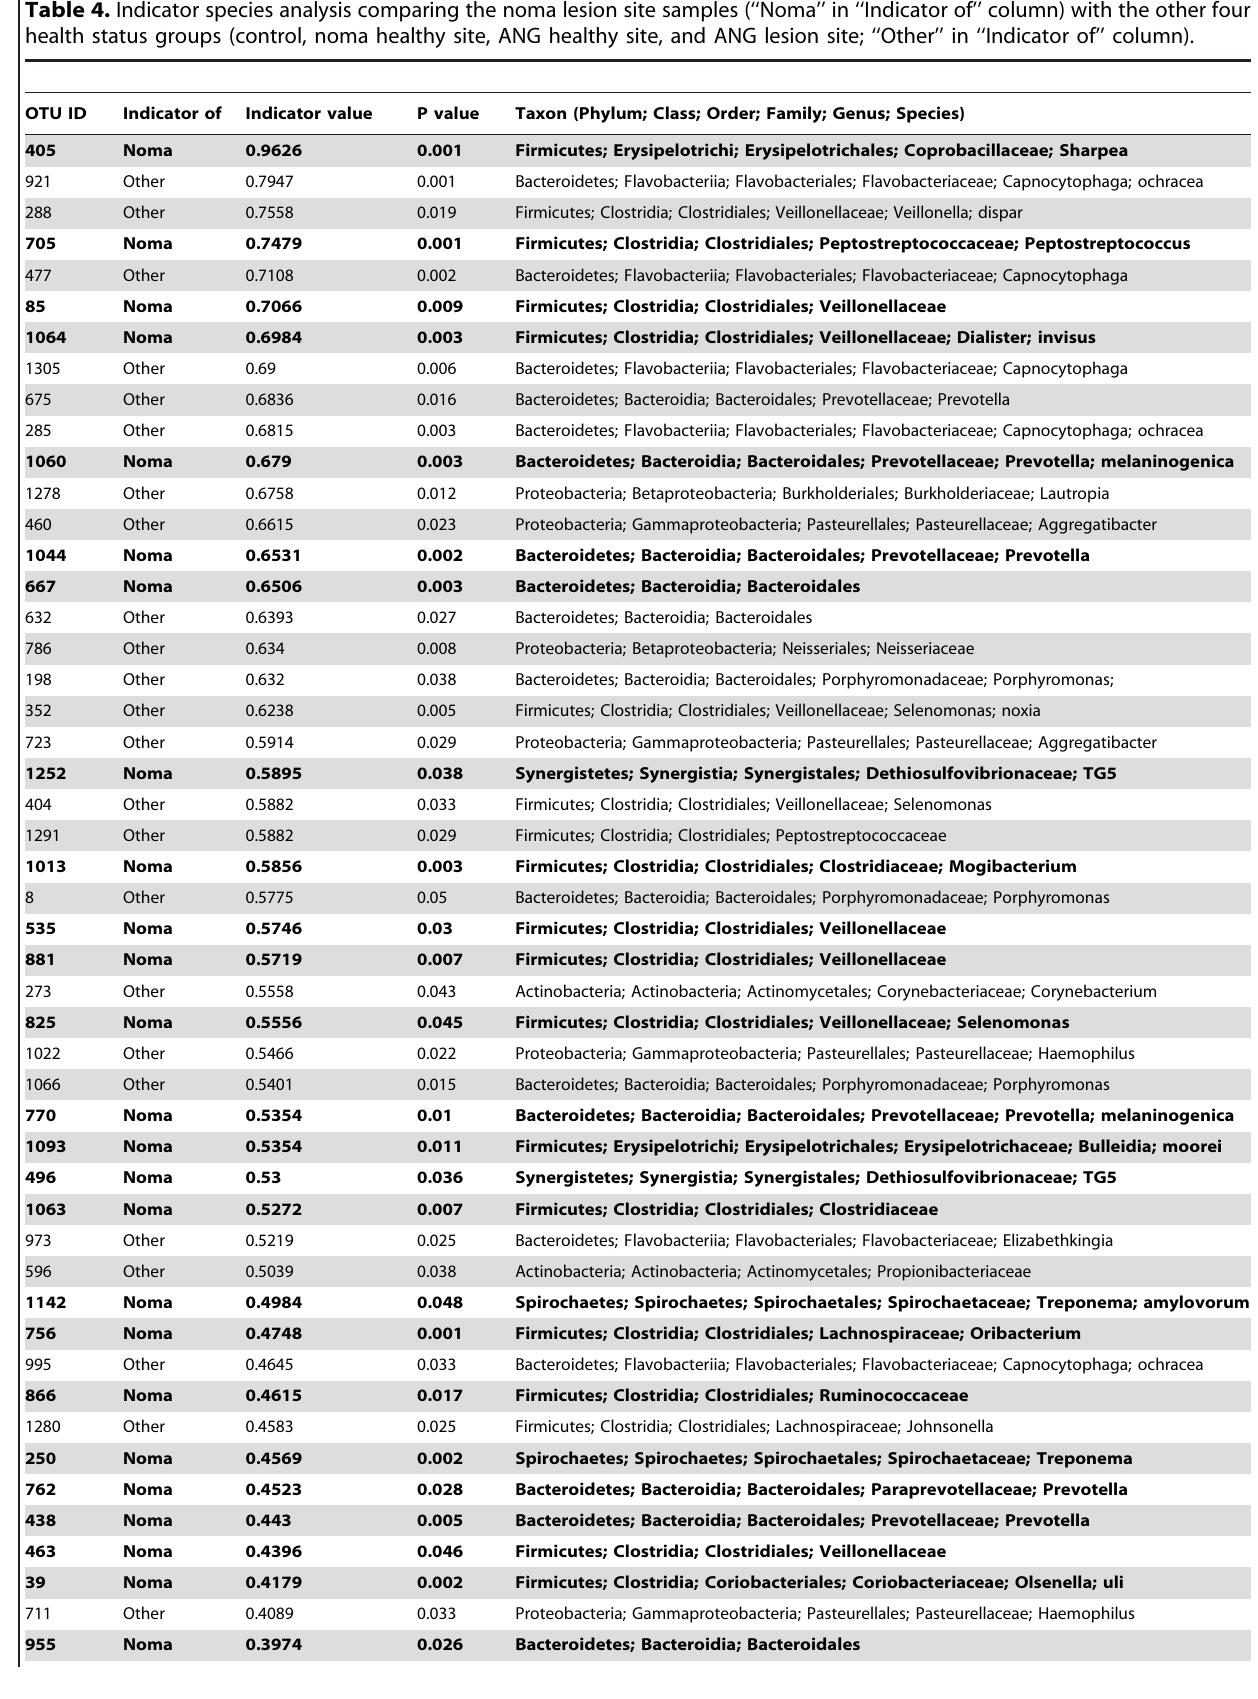
Table 4. Indicator species analysis comparing the noma lesion site samples (‘‘Noma’’ in ‘‘Indicator of’’ column) with the other four health status groups (control, noma healthy site, ANG healthy site, and ANG lesion site; ‘‘Other’’ in ‘‘Indicator of’’ column).